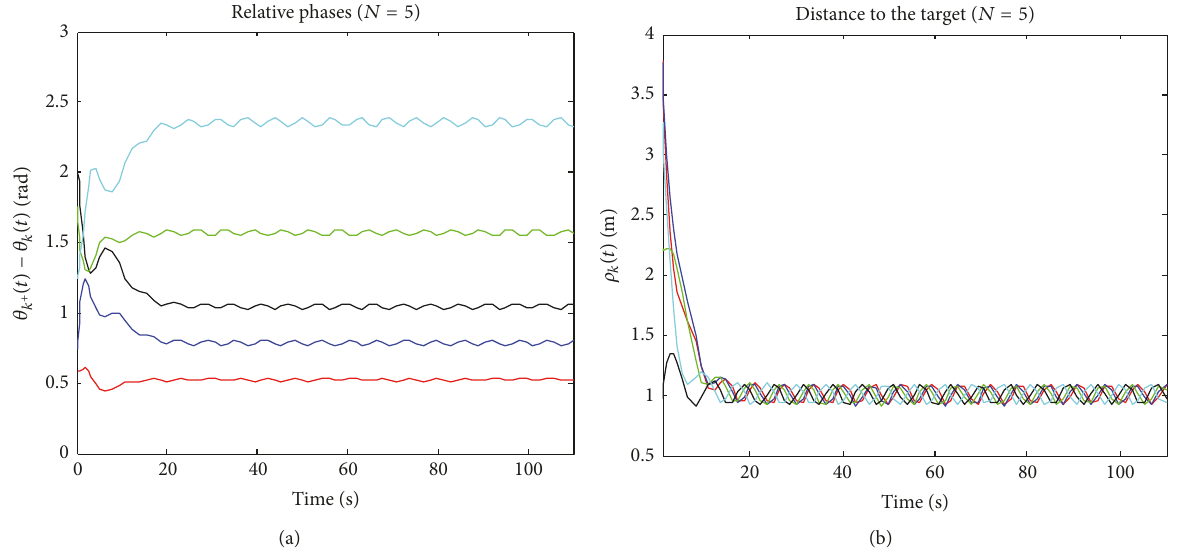
Figure 10: Trajectories with time of Figure 9. (a) Relative phases 𝜑 𝑘 + 𝑘 (𝑡) . (b) Distances to the target.